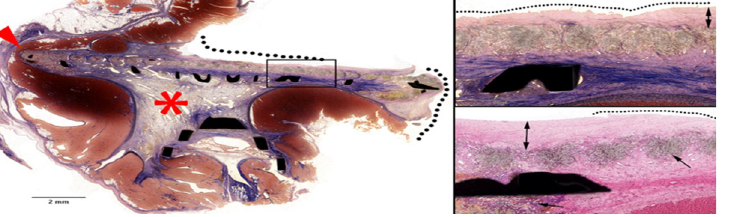
Fig 4. Histology performed on 60-day chronic canine myocardium and StrokeShield device. At left, Elastic Trichrome (ET) stain demonstrating healed and mature neointima covering the Dacron and nitinol struts (dark black shapes) of the closure device (black dotted line), fully mature fibrovascular connective tissue filling the closure device cavity (red asterisk), and occlusion point at the contact between closure device disc and atrial wall with normal healing (red arrowhead). The black box is further detailed in the upper right image (ET stain). Here, the dotted line indicates healed and mature neointima covering the closure device with irregular edges and microtears indicative of handling artifact. The black double arrow is mature fibrocellular neointima lining the Dacron cover. At lower right, Hematoxylin and eosin stain (H&E) (lower right) showing healed and mature neointima (dotted line) covering the closure device with irregular edges and microtears indicative of handling artifact. The black double arrow shows mature fibrocellular neointima lining the Dacron cover and the single arrow shows Dacron with expected minimal to mild foreign body inflammatory response